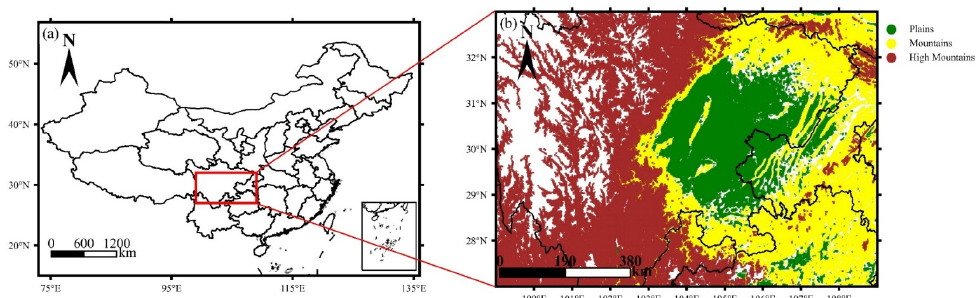
Figure 1. Administrative regional division of the People’s Republic of China ( a ), and geographical division of Sichuan Basin and its surrounding areas; ( b ) The green, yellow and brown areas represent the plains, mountains and high mountains respectively. Table 1. Number of convective and stratiform rainy pixels of different types of terrain in Sichuan Basin and its surrounding detected by GPM DPR from May to September of 2014–2021. RR (mm/h) Plain Mountain